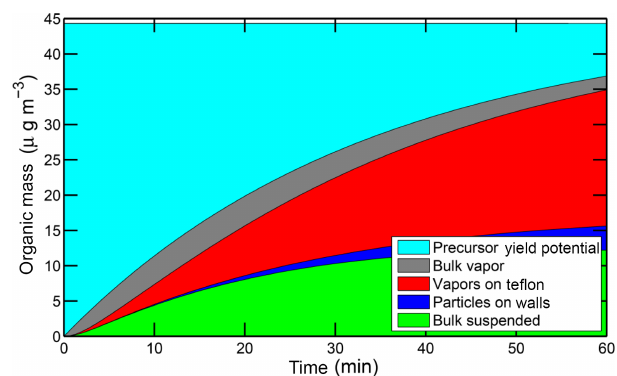
Figure 13. Dynamical simulation of the SOA production from 6ppb of PD with a mass accommodation coefficient α = 1. The simu- lation treats five different reservoirs: unreacted precursor, vapors, suspended particles, deposited particles, and sorption to Teflon, as shown in the legend. The simulation reproduces the SOA observed on the suspended